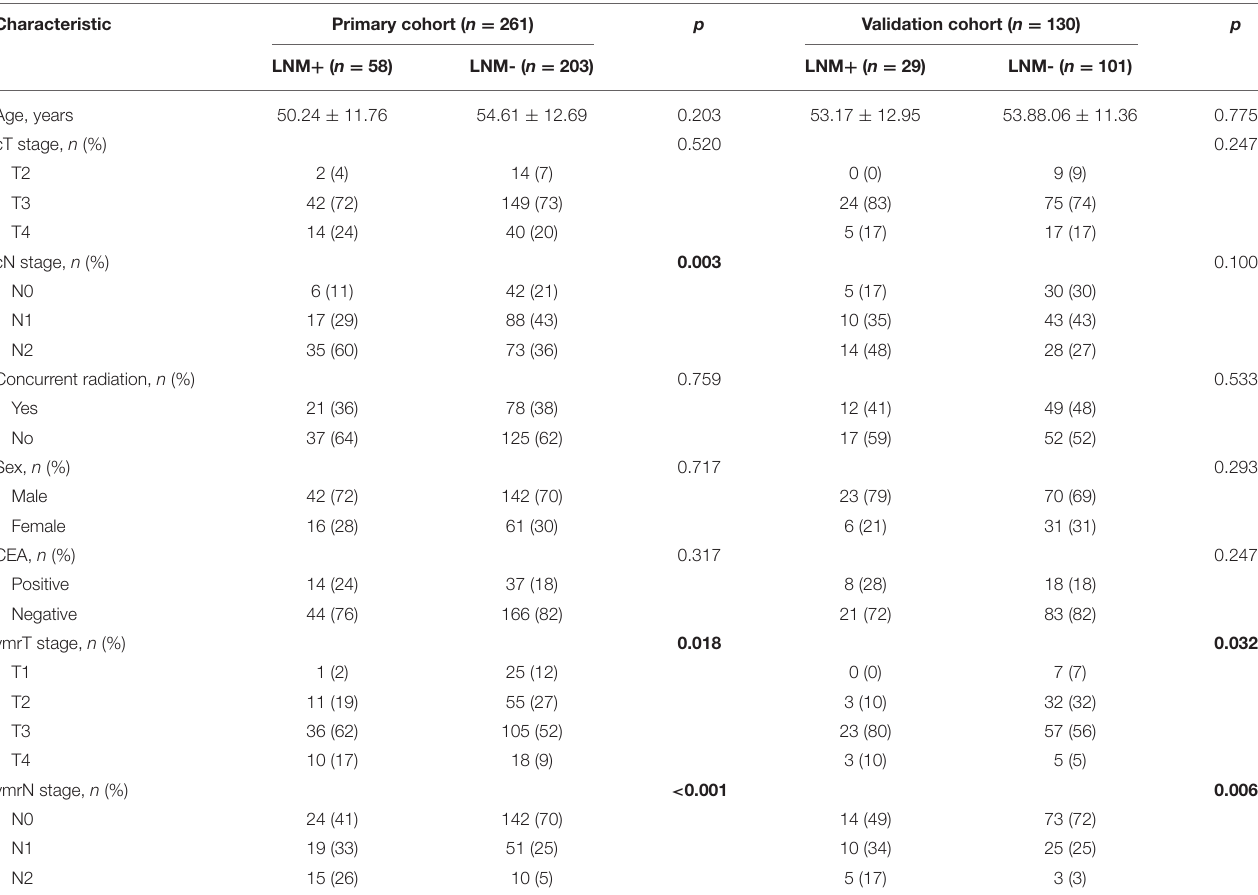
TABLE 1 | Clinical characteristics of patients in primary and validation cohorts.